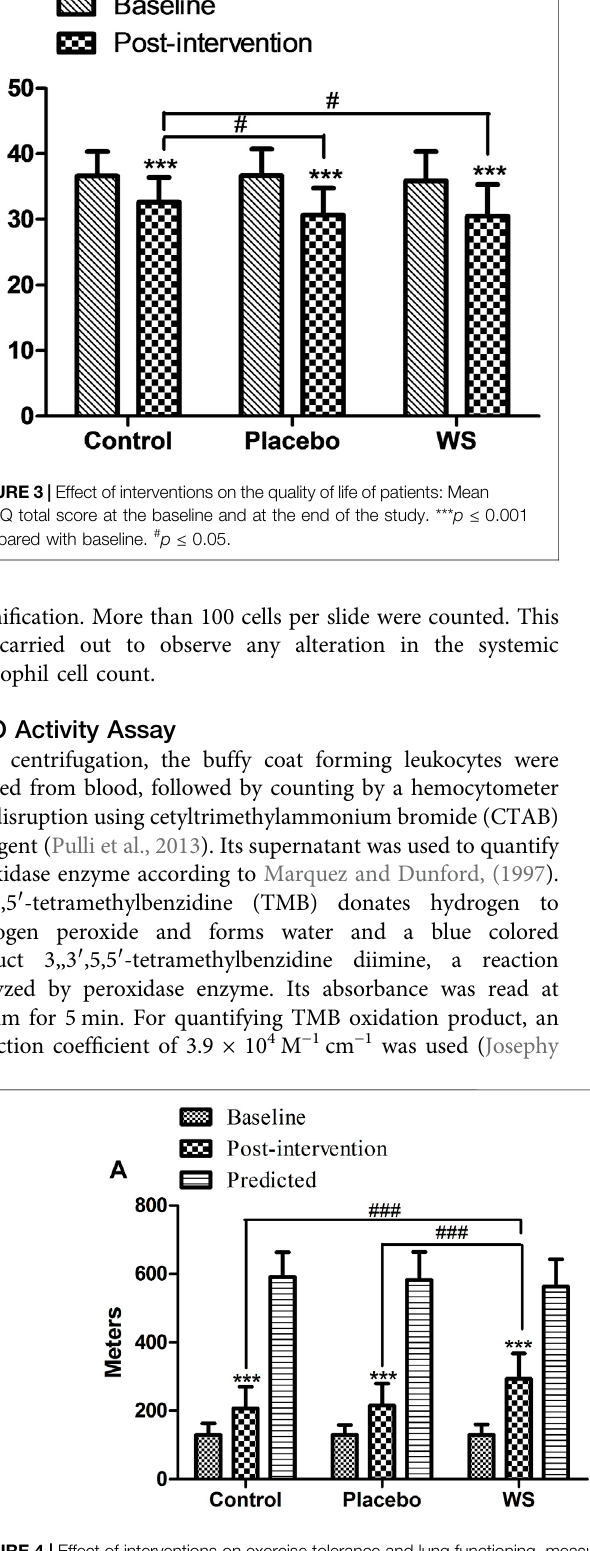
Frontiers in Pharmacology |